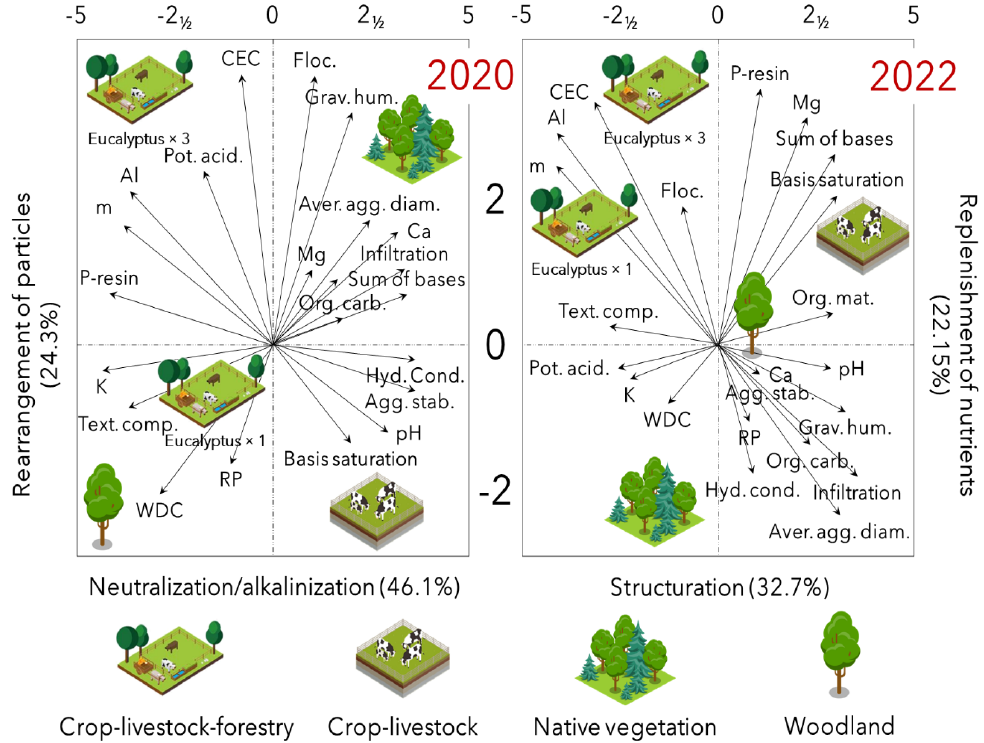
Figure 5. Factorial mapping of indicators of environmental reclamation to integrative systems; saturation of aluminum, m; cation exchange capacity, CEC; water-dispersing clay, WDP; resistance to penetration, RP.